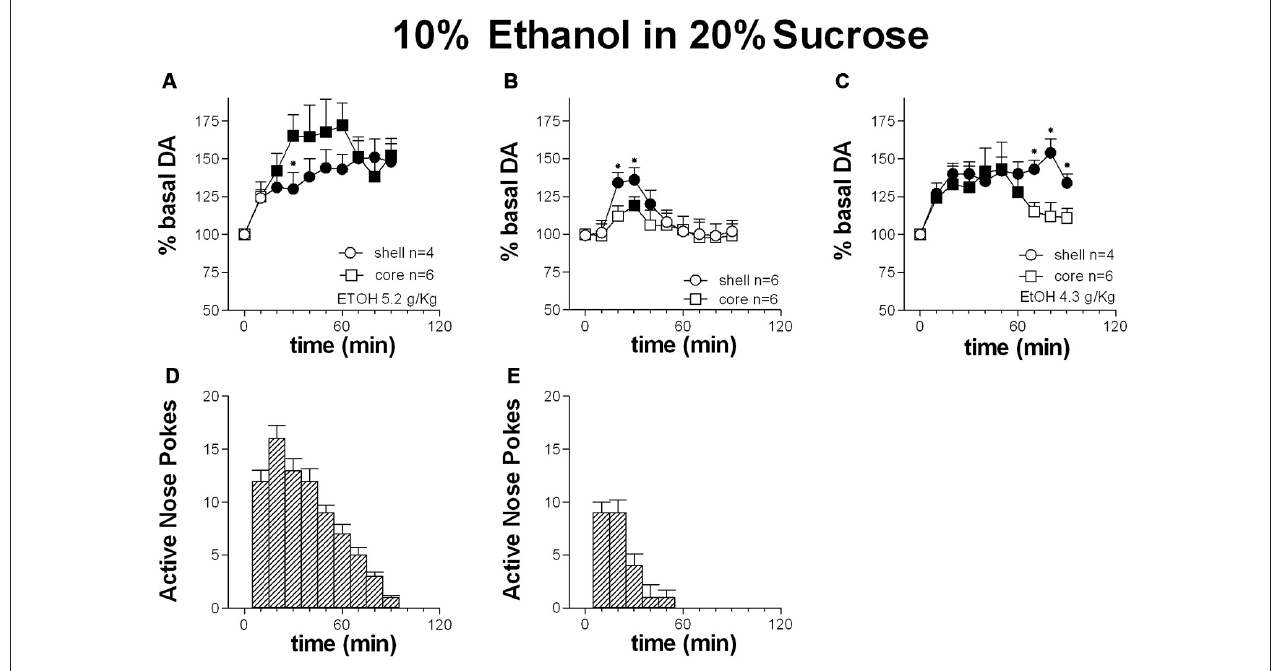
FIGURE 7 | Time-course of dialysate DA in the NAc shell (circles) and core (squares) and active nose pokes (Bars) every 10 min under FR1 responding for 10% ethanol in 20% sucrose solution (A,D) , extinction (B,E) and non-contingent 10% ethanol in 20% sucrose solution presentation (C) . Data are means ± SEM of the results, expressed as % of basal values, obtained in the number ( N ) of rats indicated in the figure. Filled symbols: p < 0.05 vs. basal values; ∗ p < 0.05 vs. values obtained in the